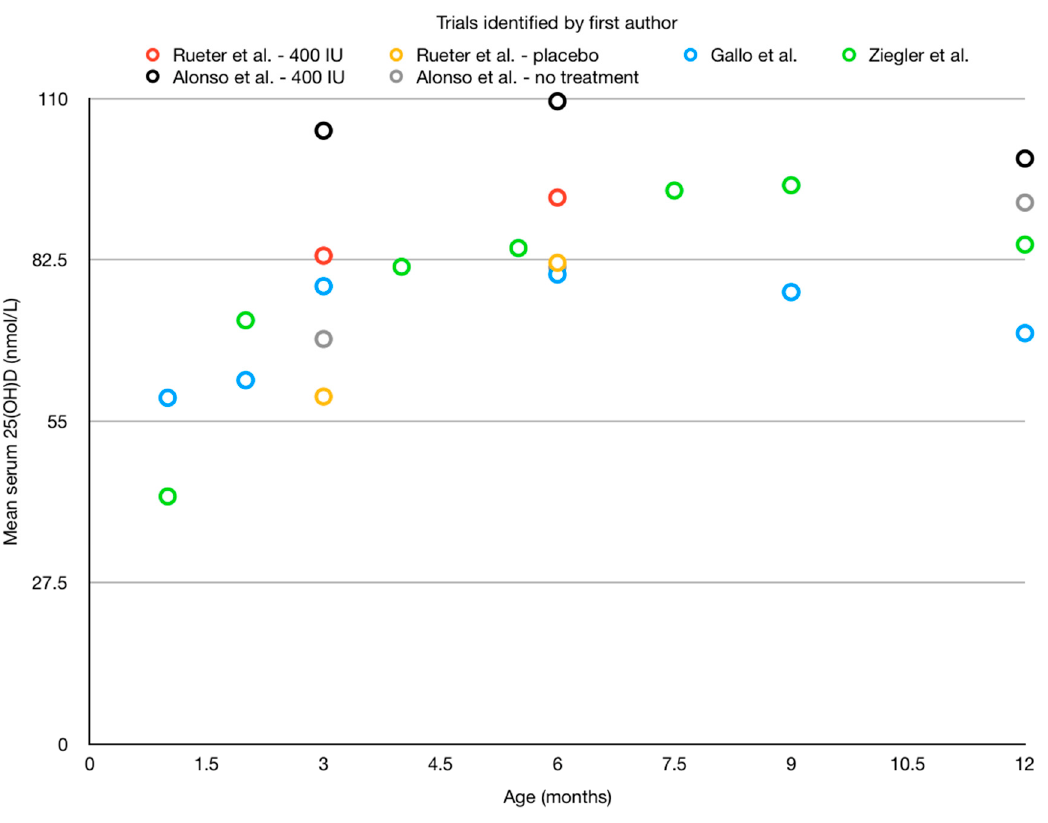
Figure 1. Mean serum 25-hydroxyvitamin D (25(OH)D) measurements in randomized controlled trials (RCTs) assessing 400 IU/day vitamin D supplementation in 1–12-month-old infants. These measurements are the mean serum 25(OH)D at each timepoint in each experimental group which received 400 IU of vitamin D supplementation in these studies.